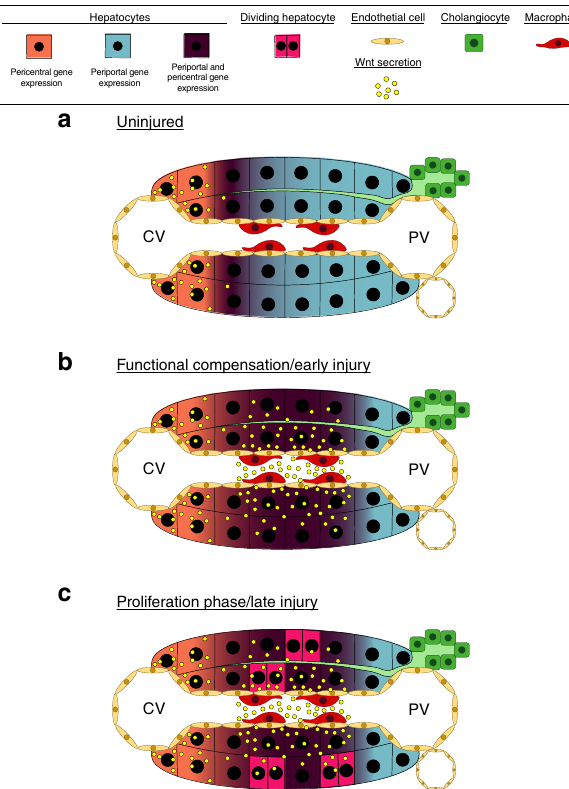
Fig. 6 Model of hepatocyte response to acute liver injury. a Wnt secretion from the pericentral endothelium functions in the maintenance of the pericentral gene expression gradient in normal, quiescent liver. b Wnt secretion from macrophages aids in functional compensation of midzonal and periportal hepatocytes during the pre-proliferation phase of acute liver injury. c Wnt secreation is essential for both functional compensation and activation of the proliferative response during regeneration. Compensating hepatocytes contribute to a maintenance of hepatic function, whereas proliferating hepatocytes selectively down-regulate a subset of hepatic